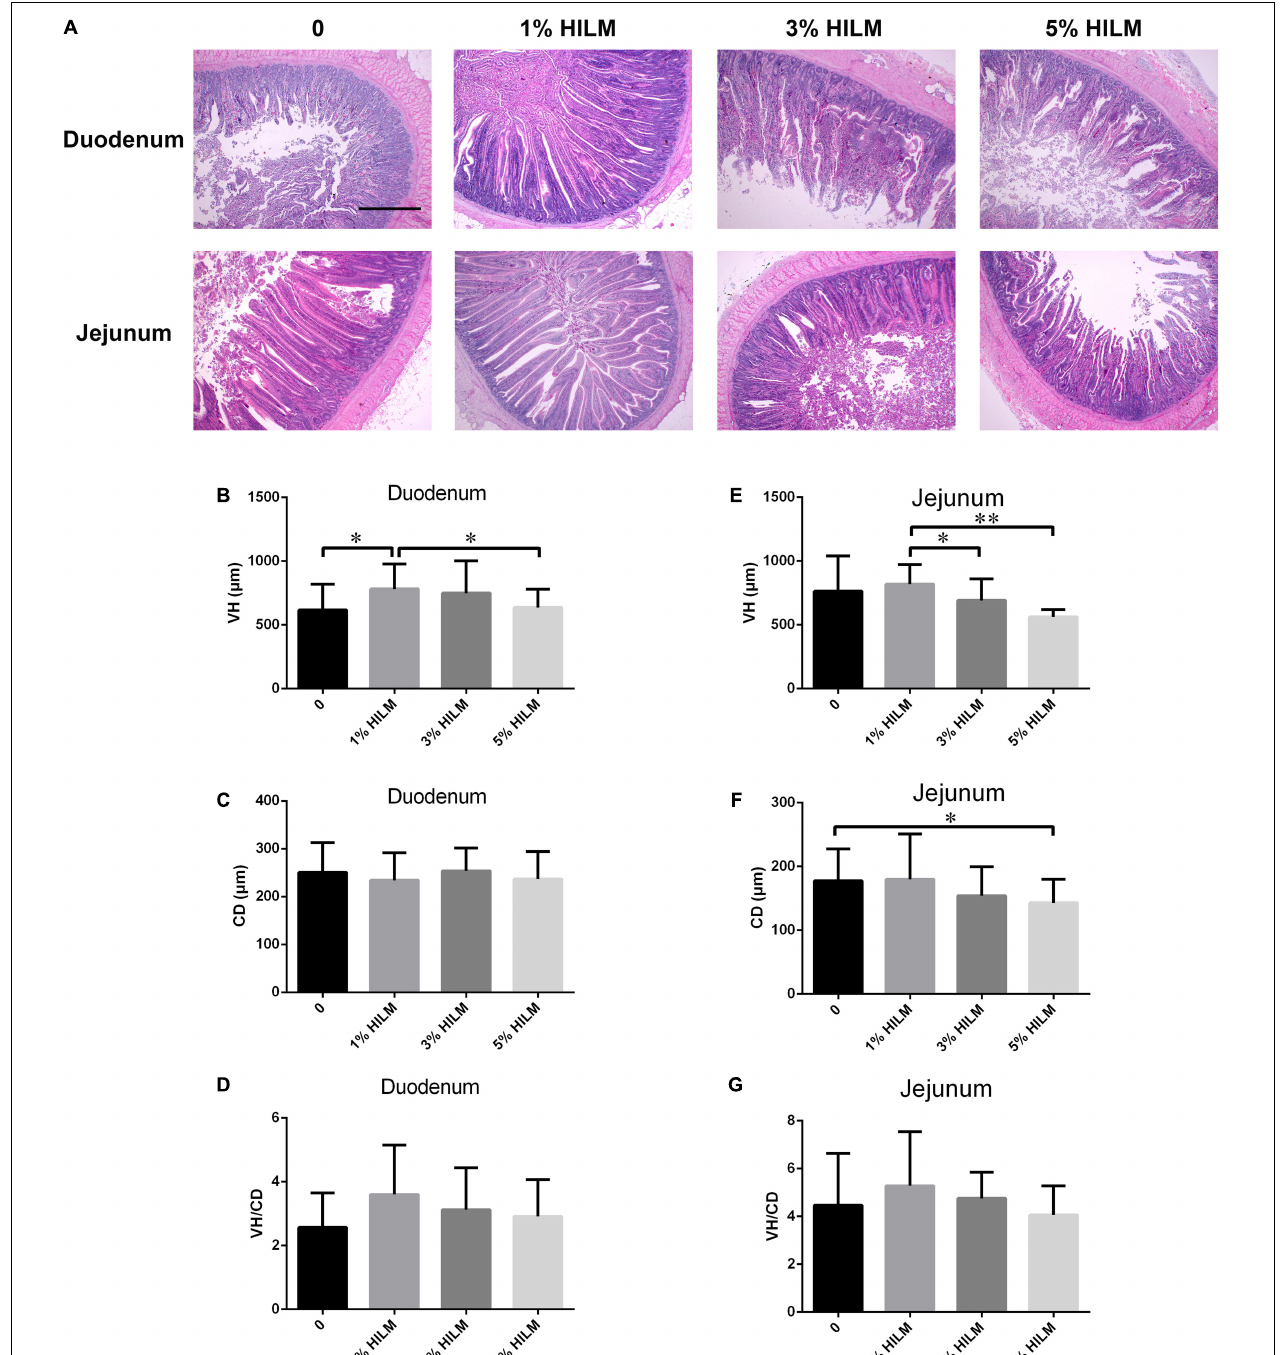
FIGURE 1 | Effects of HILM on intestinal morphology of Xuefeng black-bone chicken. (A) Representative pictures of hematoxylin and eosin staining (40 × , scale bar: 20 µ m); VH of duodenum (B) and jejunum (E) ; CD of duodenum (C) and jejunum (F) ; VH/CD of duodenum (D) and jejunum (G) . Results shown are means ± SEM ( n = 12). ∗ p < 0.05, ∗∗ p < 0.01. VH, villus height; CD, crypt depth; VH/CD, ratio of villus height to crypt depth; HILM, Hermetia illucens larvae